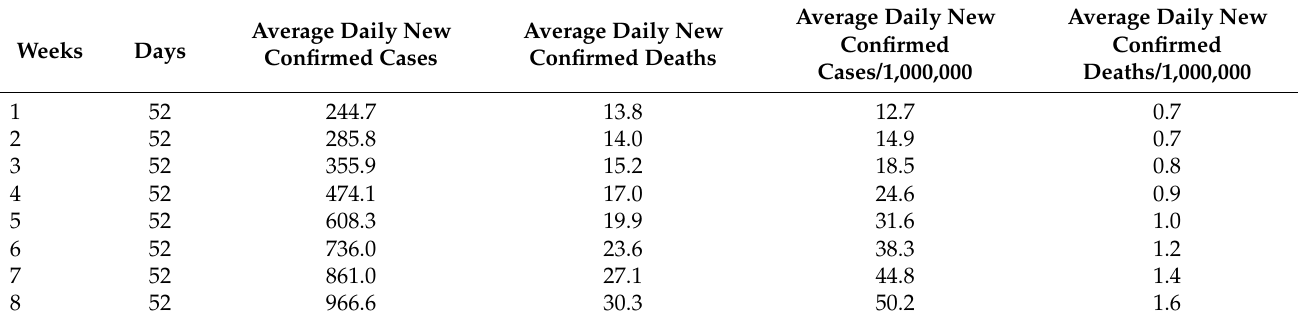
Table 3. Average number of cases after lockdown in Romania.